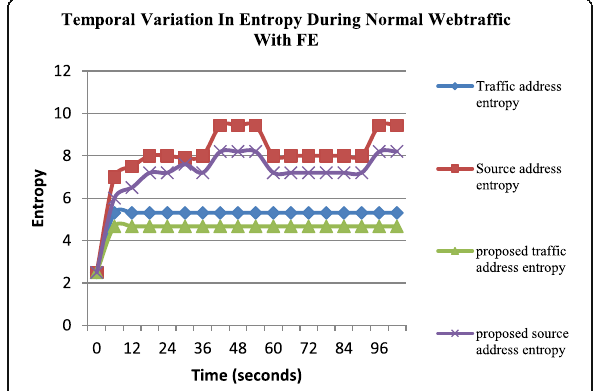
Fig. 5 Temporal variation in entropy during normal web traffic with FE. Source address entropy and traffic address entropy are presented. The observations are made during a flash event